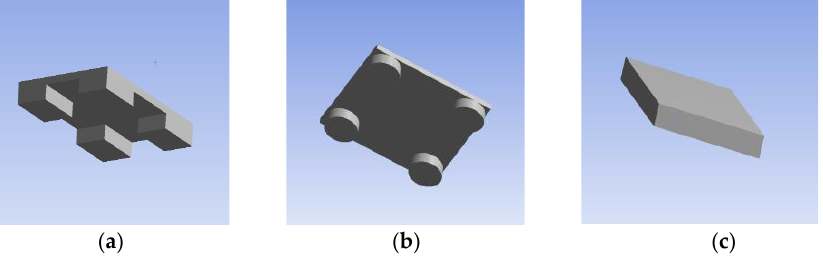
Figure 9. Simplified model diagram of the three frames: ( a ) simplified model diagram of a square pillar support frame; ( b ) simplified model diagram of a circular pillar support frame; ( c ) simplified model diagram of a plane frame.